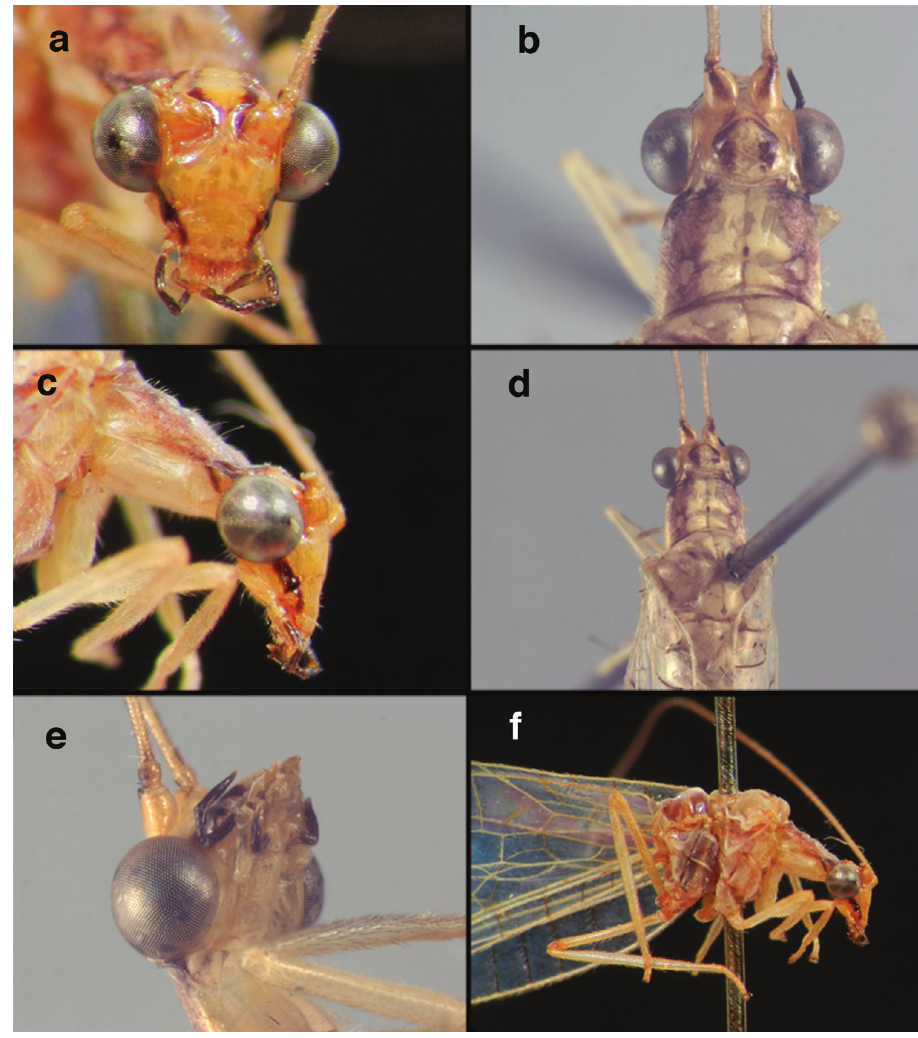
Figure 93. Ungla yutajensis Sosa: External features, ( a ) head, frontal ( b ) head, prothorax, dorsal ( c ) head, prothorax, lateral ( d ) head, prothorax, dorsal ( e ) head, ventral ( f ) head, thorax, lateral (all: Venezuela, Amazonas, female: a, c, f holotype, MIZA, images FS; b, d, e USNM). Redescription. Head yellow dorsally; vertex smooth, shiny; inverted U-shaped marking prominent, dark red, broad posteriorly, separated or lightly connected an- teromesally, not extending anteriorly to area between scapes; dorsal antennal fossa pale, with dark reddish stripe mesally, reaching mesal base of scape; area between eyes and posterior half of vertex cream-colored, unmarked; frons, clypeus yellow, without markings; gena with large, black mark from eyes onto clypeus; tentorial pits amber. Antenna with scape cream-colored, with broad, diffuse dark red stripe extending